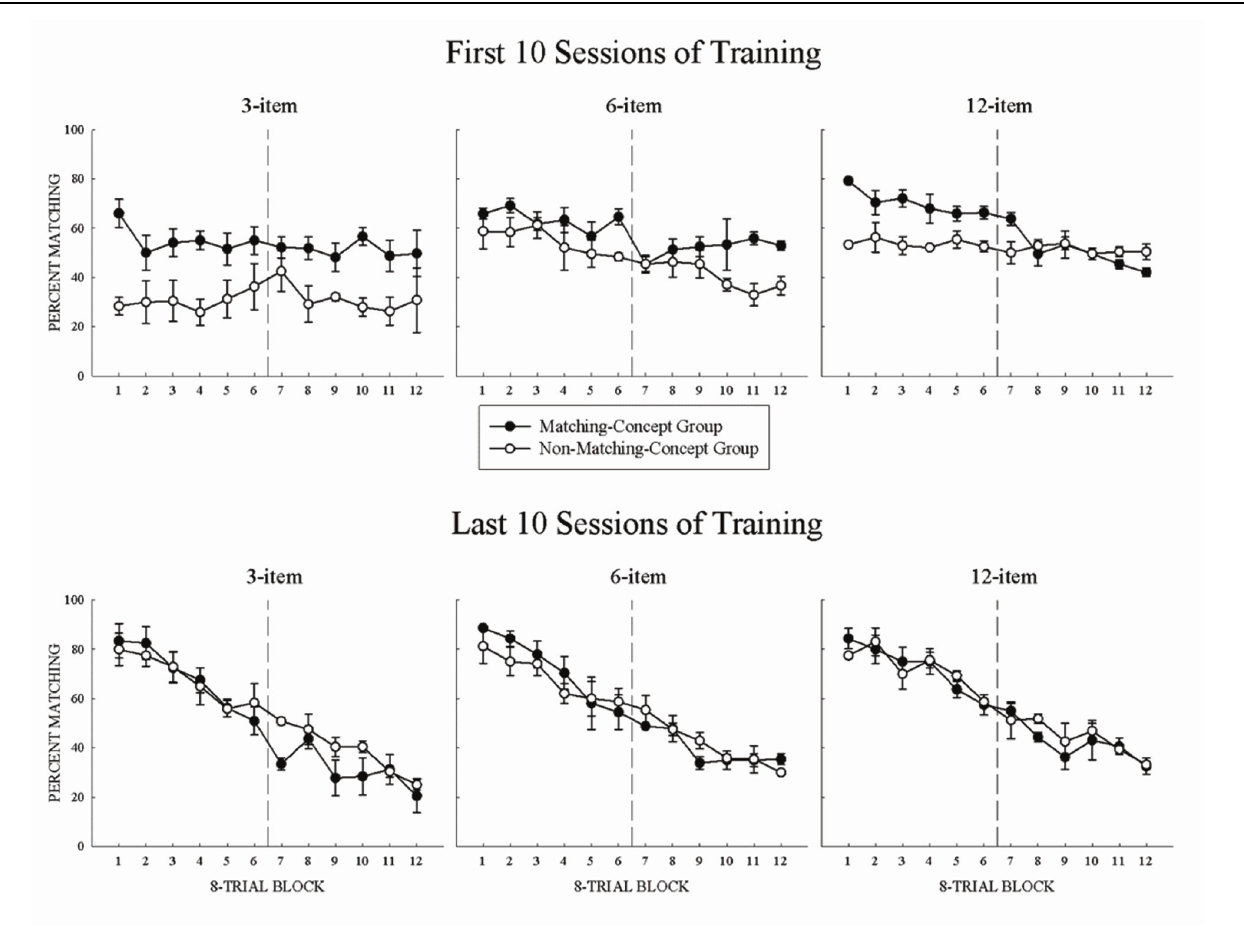
FIGURE 1 | (Top panels) Mean percent correct matching for the first 10 sessions of acquisition across 8-Trial Blocks for the matching-concept group (MCG; filled symbols) and non-matching-concept group (NMCG; open symbols). (Bottom panels) Mean percent correct matching for the final 10 sessions of acquisition across 8-Trial Blocks plotted by group. Error bars represent